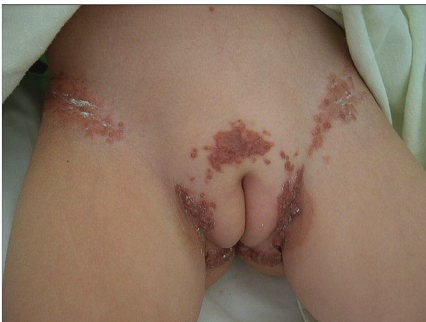
Figure 4: Hematoxylin and eosin stain of bone marrow biopsy showed significant hypercellularity with over 90% blasts with L1 morphology; original magnification × 1000.